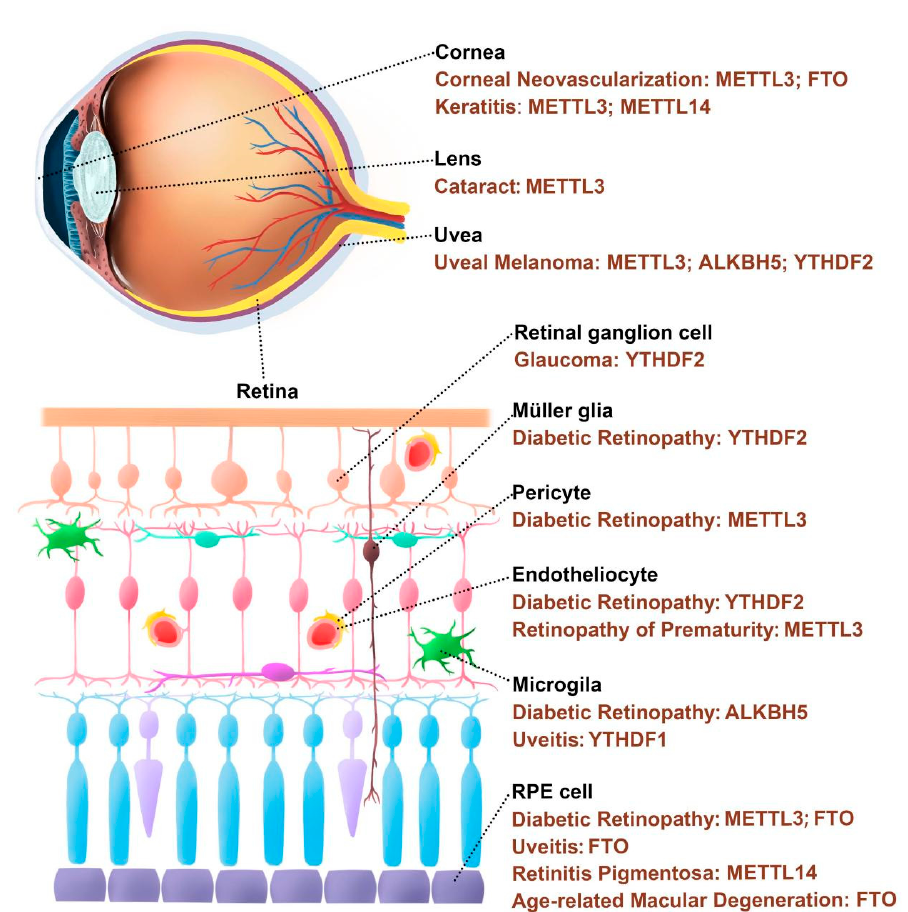
Figure 1. m6A regulatory proteins are involved in the occurrence and development of eye